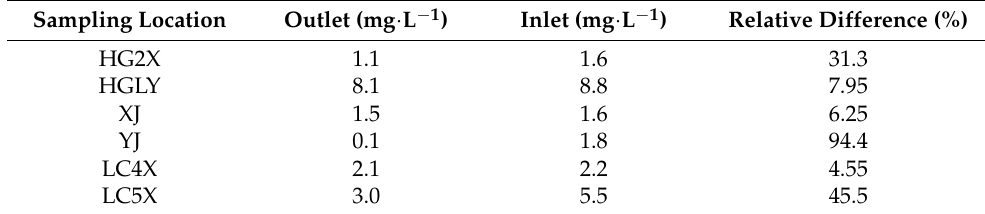
Table 1. POC test results of circulating water system.